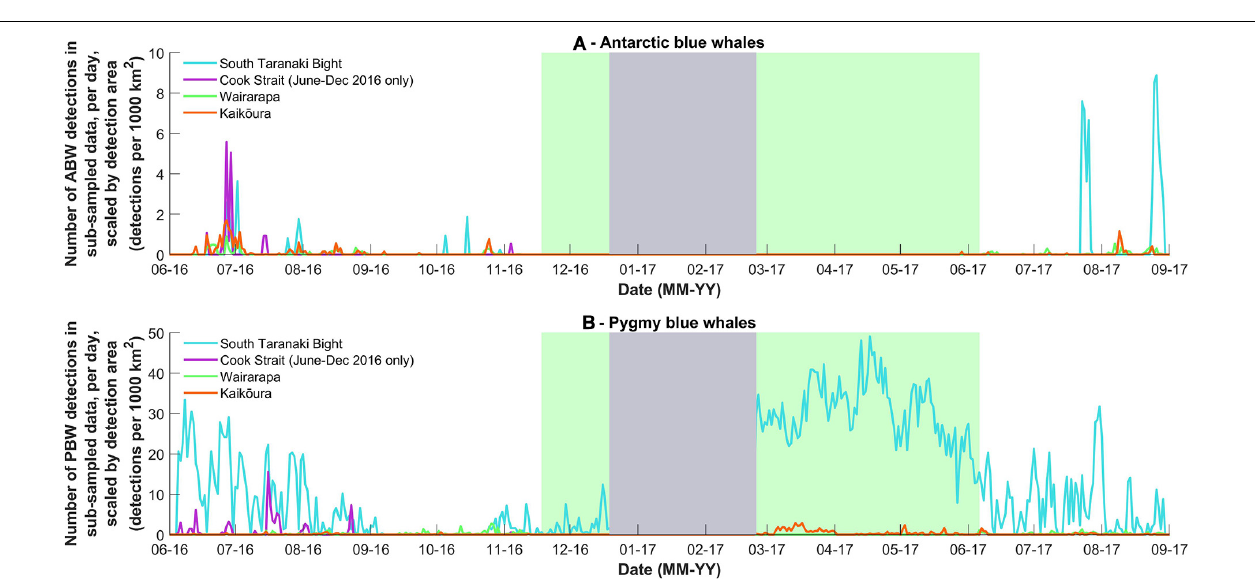
FIGURE 4 | (A) The number of Antarctic blue whale and (B) pygmy blue whale calls detected per day in the stratified random subsample of data from 2016 and 2017, normalised by the detection area of each recording location (calculated for June 2016 or March 2017, respectively) to give daily detections per 1000 km 2 . The grey and green blocks are as described in Figure 3 . Note Y -axis scale differs between